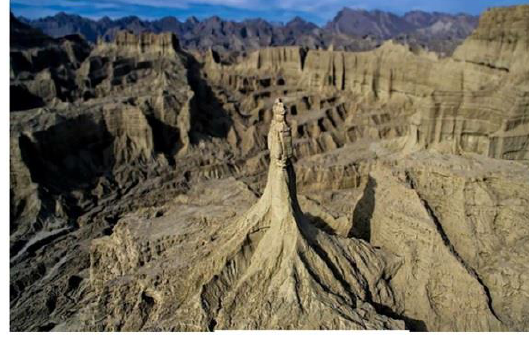
Fig. 2. Sapta Beach, Hingol National Park Fig. 3. Princes of Hope, Hingol National